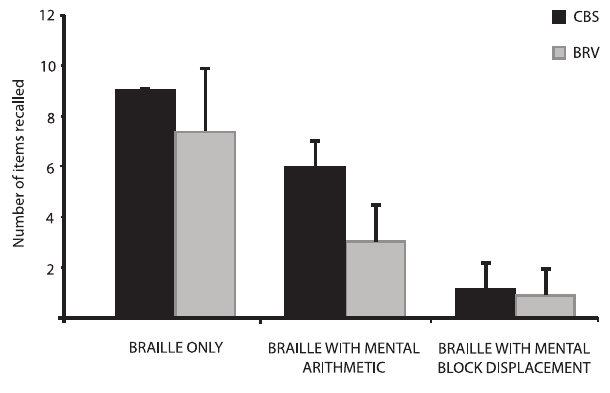
Figure 3. Results of the Braille task (Experiment 2). The added tasks of mental arithmetic and mental displacement of blocks significantly affected performance for both groups. Additionally, the spatial task affected significantly more than the non-spatial one, again for both groups, indicating that the tactile module of working memory is more spatial in nature. Note that the error bar is 0 for the CBS group performing the Braille task alone as all of the subjects recalled the same number of items, possibly reflecting a ceiling